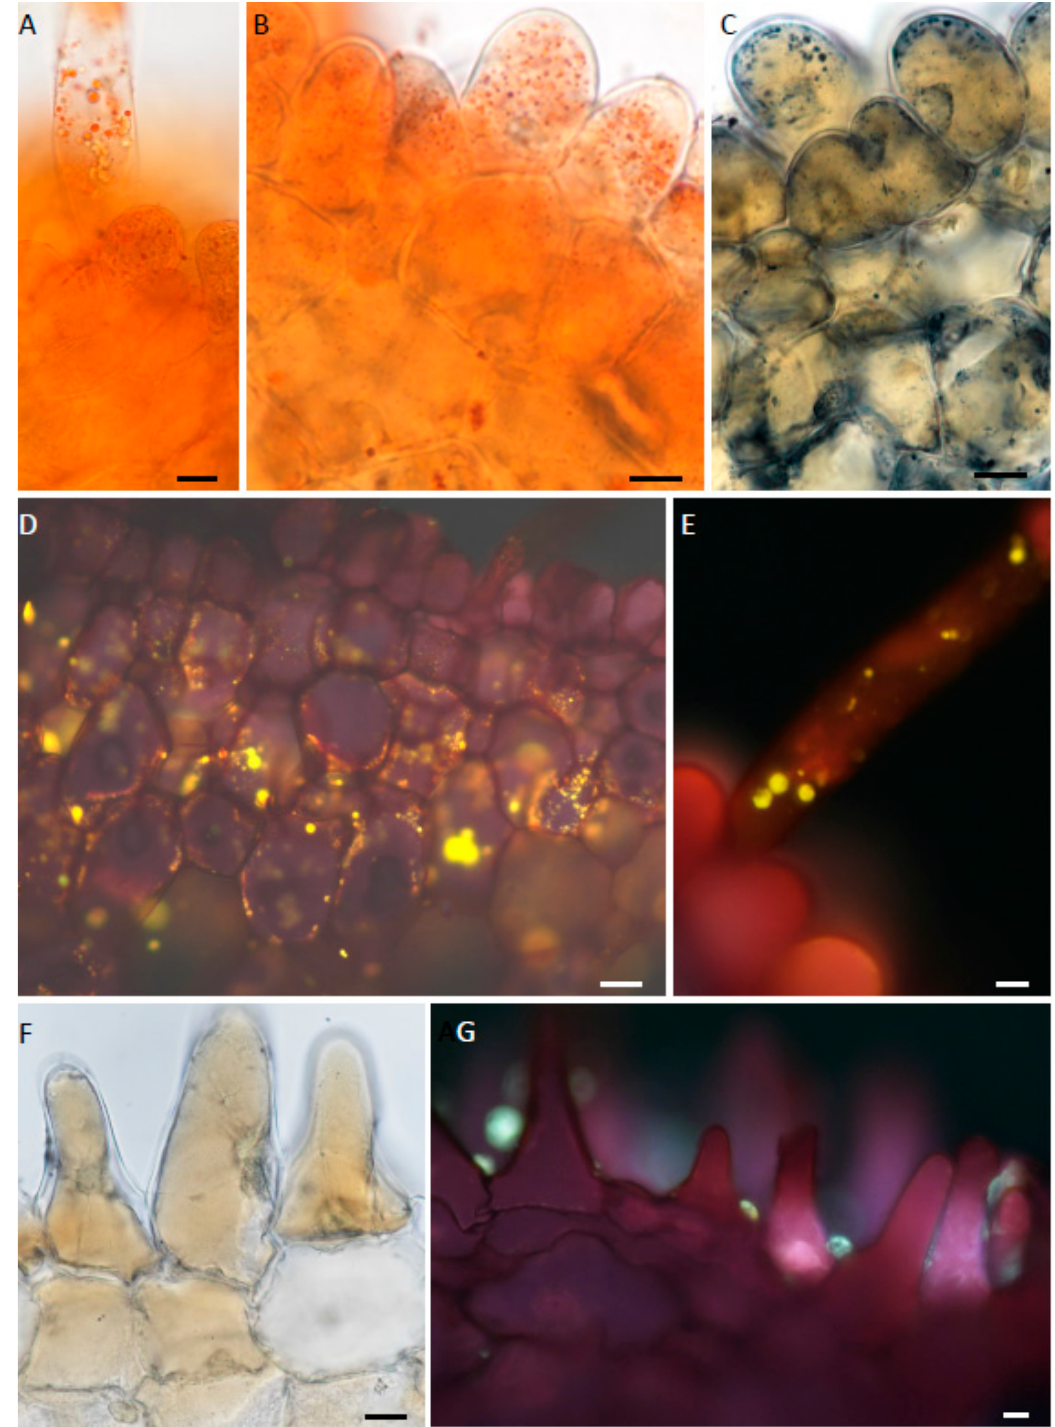
Figure 7. ( A – G ). Histochemistry of labellar tissue. ( A , B ). Labellar tissues treated with Sudan IV, and ( C )., with SBB for lipids. ( A ). Lipid droplets in a trichome of M. ochroleuca . ( B ). Numerous minute lipid droplets in papillae of M. pauciflora . ( C ). Darkly stained lipid droplets in epidermal papillae and subepidermal cells of M. ochroleuca . ( D , E , G ). Labellar tissues stained with NR followed by fluorescence microscopy. ( D , E ). Lipid droplets in parenchyma cells and in a trichome, respectively, of M. ochroleuca , appear yellow-green. ( F ). Treatment with SBB did not detect lipids in the epidermal papillae of M. weberbaueri . ( G ). Surface secretion occurs between and upon the adaxial labellar papillae of M. weberbaueri . Scale bars = 10 µ m, 20 µ m, 20 µ m, 20 µ m, 10 µ m, 20 µ m, 50 µ m,